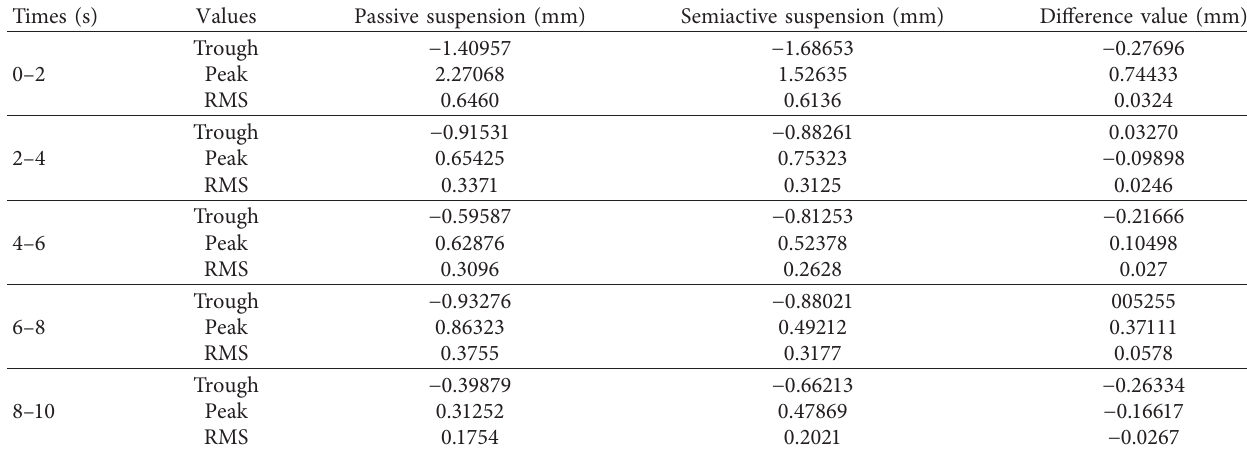
Table 7: Comparison of peak and RMS values of acceleration